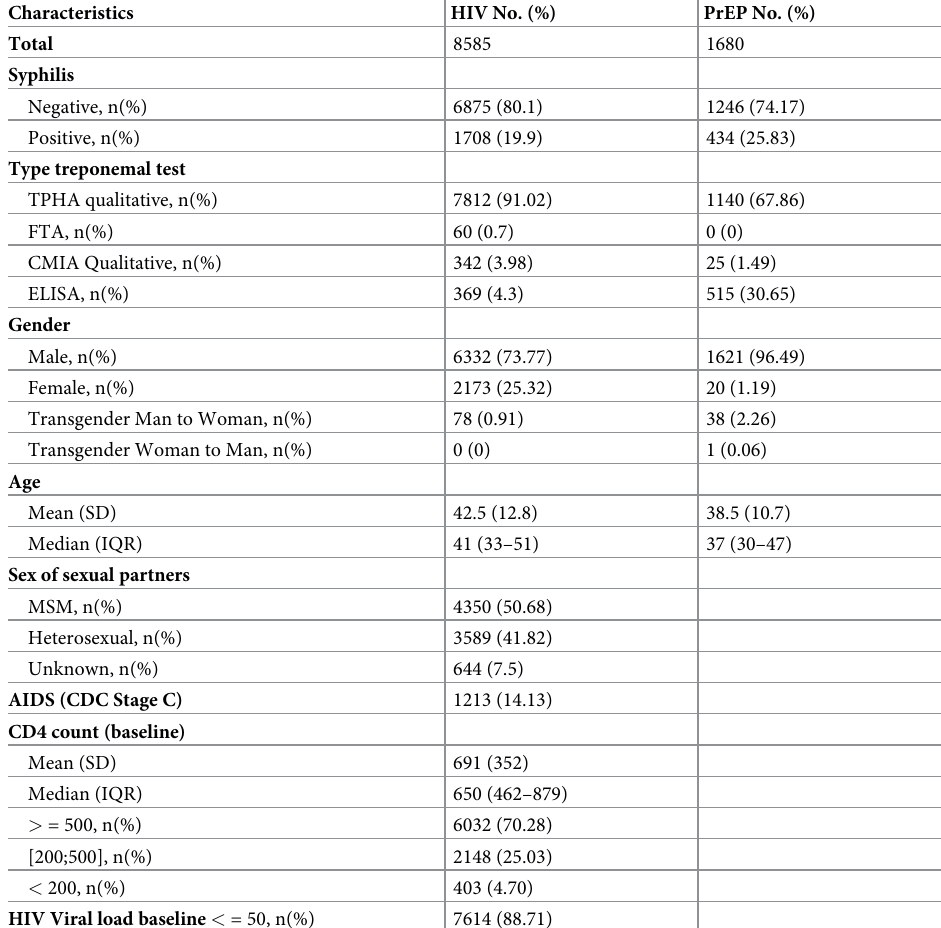
Table 1. Characteristics of participants at enrollment.